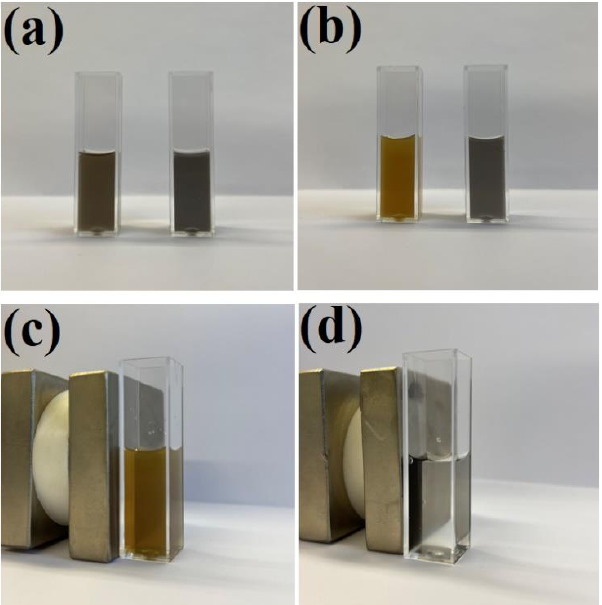
Figure 8. Photographs of sols of: ( a ) the Fe 3 O 4 @Ag (left) and (Fe 3 O 4 @Ag)@SiO 2 (right) before the addition of hydrochloric acid, ( b ) the Fe 3 O 4 @Ag (left) and (Fe 3 O 4 @Ag)@SiO 2 (right) one hour after the addition of hydrochloric acid to a final concentration of 0.1 M, ( c ) the Fe 3 O 4 @Ag one hour after the addition of hydrochloric acid — the cuvette with the sol is placed near a strong neodymium magnet — and ( d ) the (Fe 3 O 4 @Ag)@SiO 2 one hour after the addition of hydrochloric acid — the cuvette with the sol is placed near a strong neodymium magnet. The cuvette used was a standard square 3.5 mL cuvette with an optical path of 1 cm. The sols were not diluted before the photo was taken.